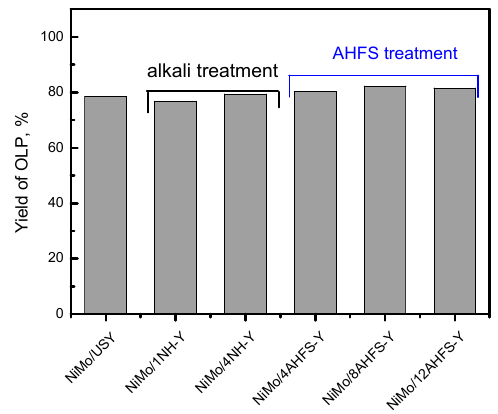
Figure 4. The yield of organic liquid product in the conversion of WCO over different catalysts.